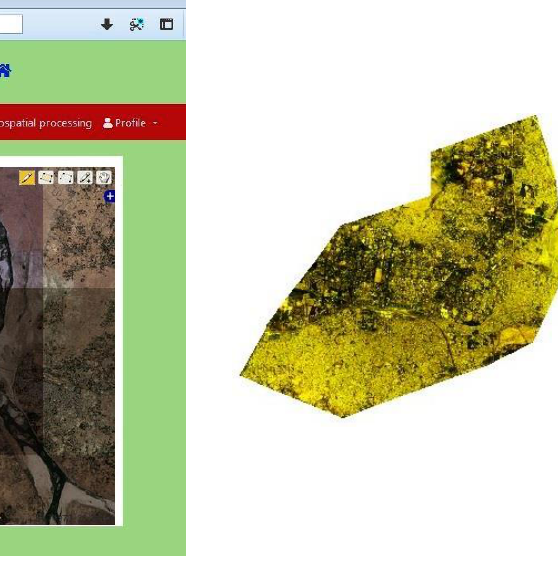
Figure 5(a). Clip operation on public health SDI using WPS Figure 5(b). Result of clip